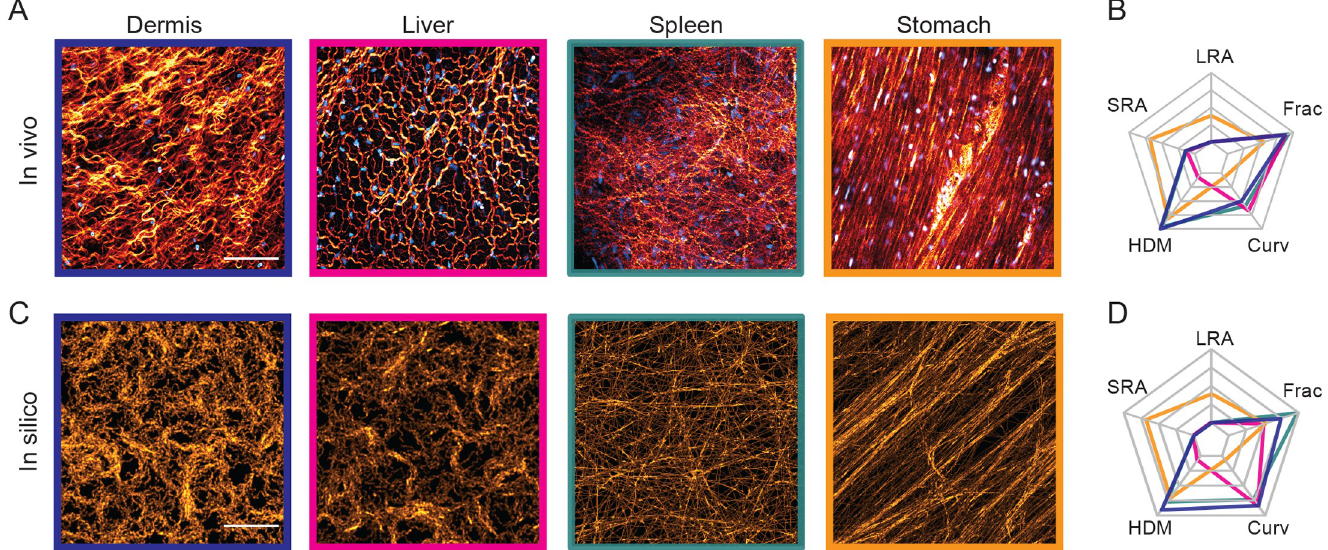
Fig 5. The model can recapitulate ECM diversity in vivo . (A) Second harmonic imaging of collagen (orange) in various tissues from a PDGFR nuclear labelled mouse. PDGFR positive nuclei (cyan) indicates fibroblast density. (B) Each matrix is characterized on a starplot below the image according to long-range alignment (LRA), short-range alignment (SRA), percentage of high density matrix (HDM), curvature (Curv) and fractal dimension (Frac). (C) In silico matrix that mimics the in vivo patterns above. Differences in parameters for generating such matrix patterns are given in Table 1. (D) Corresponding normalized starplot of in silico matrix. Scale bars represent 100 μ m.